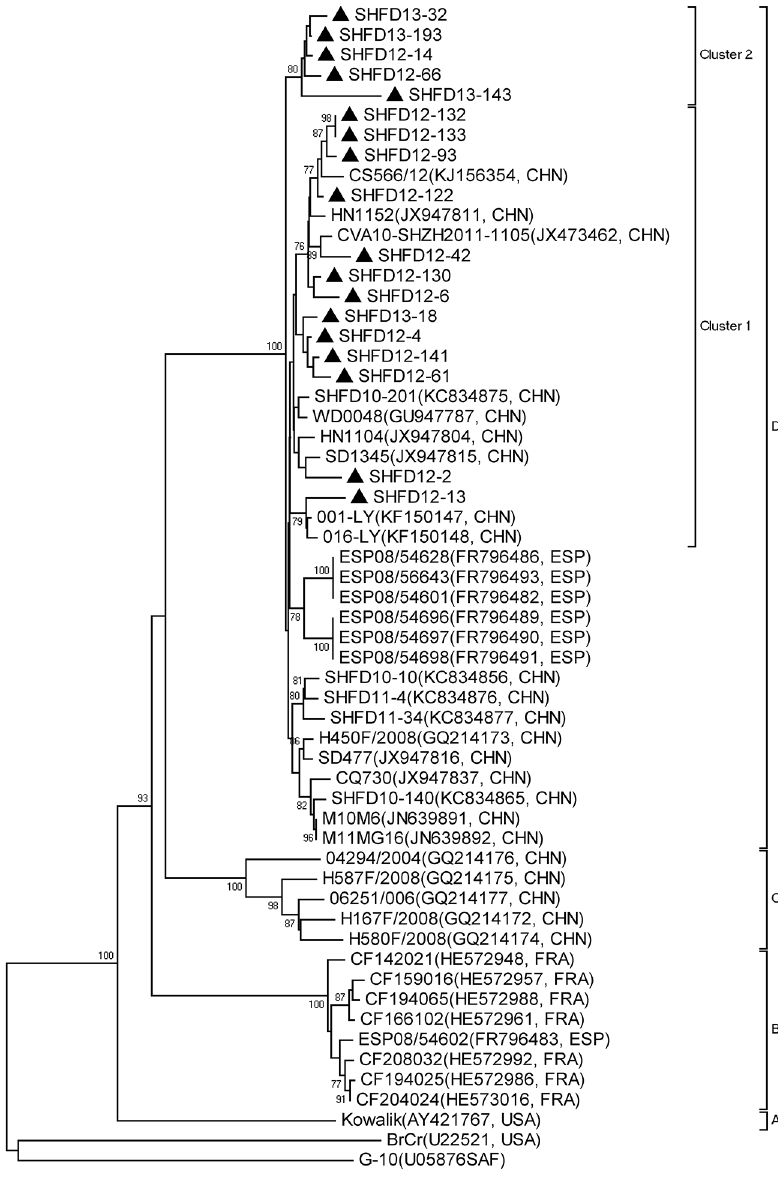
Fig 4. Phylogenetic analysis with the neighbor-joining method with a 1000-bootstrap re-sampling based on the alignment of the 394 nucleotide VP1 gene of 18 Shanghai CA10 strains. The strains labeled with ▲ were obtained in our